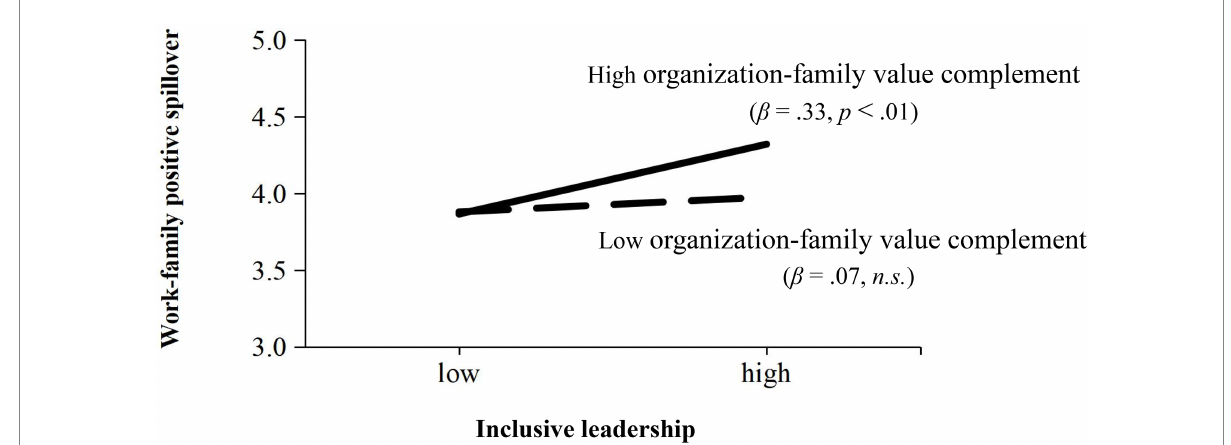
FIGURE 2 Interaction of inclusive leadership and work-family value complement on work-family positive